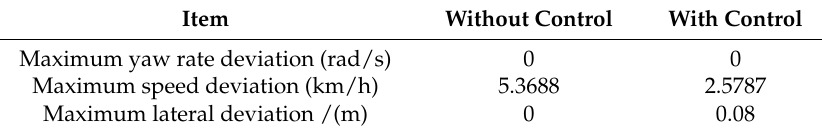
Figure 8. Experimental comparison with/without control under E2 condition. Table 11. Statistical control effect under E2 condition.